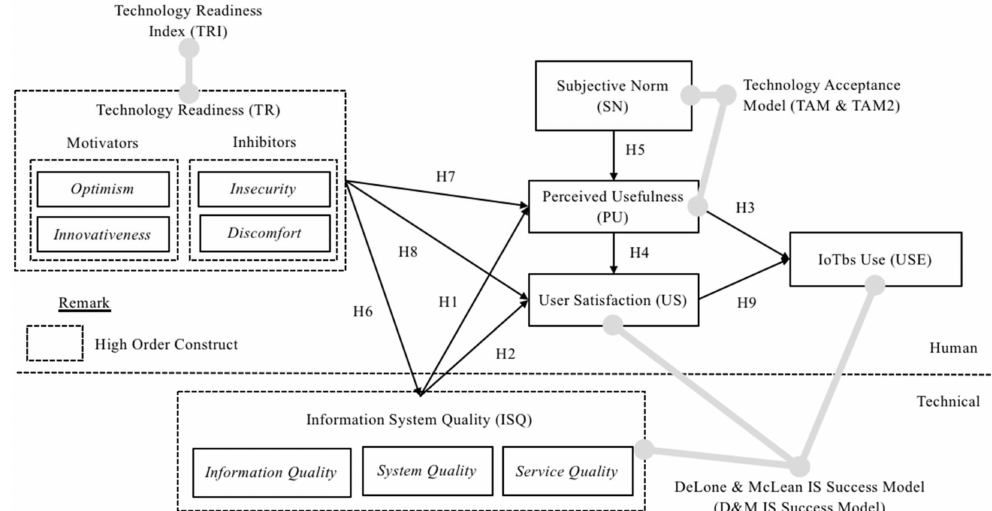
Figure 1. Research